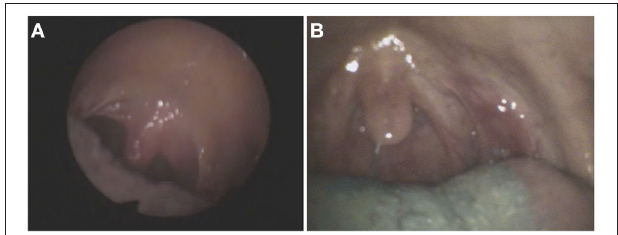
FIGURE 5 | Fiberoptic endoscopic footage (FEES) of two patients (A,B) with HOD and dysphagia who showed involuntary movements of the soft palate and pharynx due to rhythmic contraction of the levator veli palatine, so-called palatal tremor (images used with permission from Dr. medic. Sriramya Lapa,